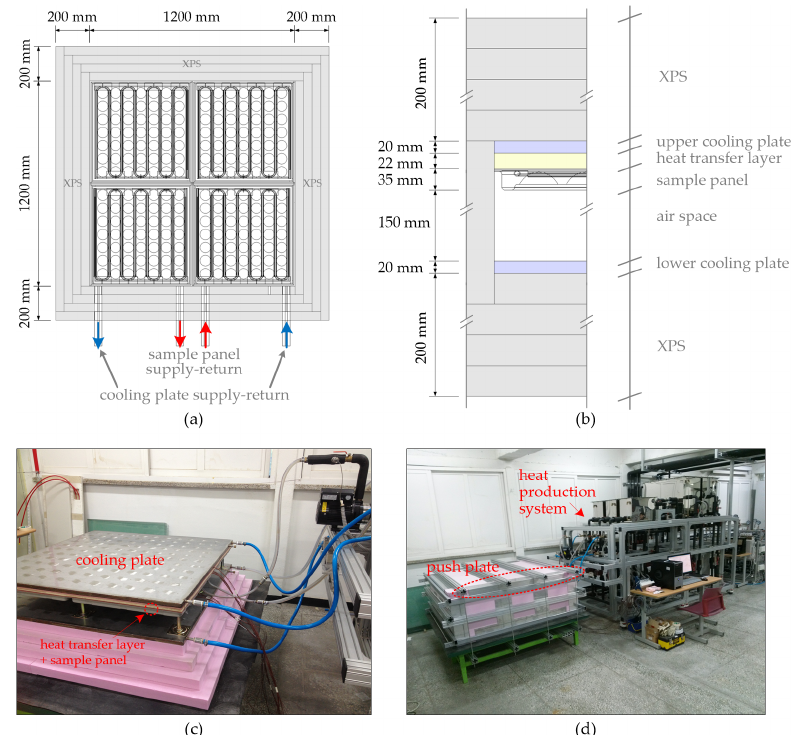
Figure 5. Experimental setup: ( a ) Plan view of the completed experimental setup. ( b ) Section view of the completed experimental setup. ( c ) Experimental setup prior to insulation closures. ( d ) The completed experimental setup used in this